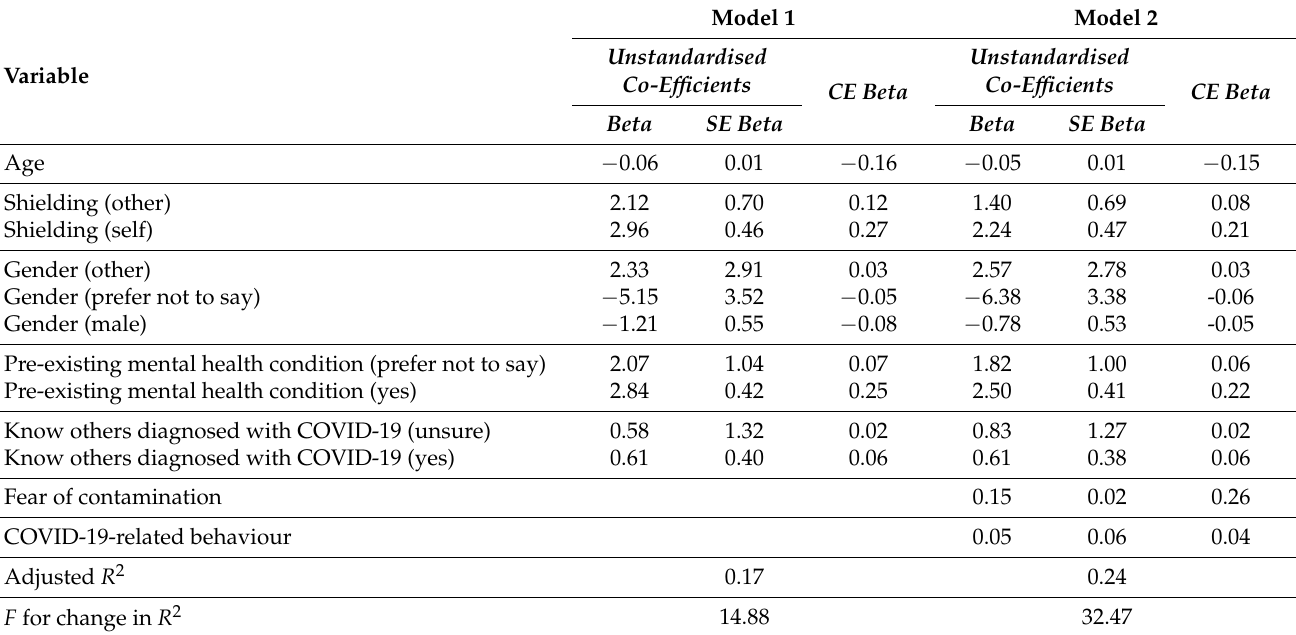
Table 6. Summary of hierarchical multiple regression for predicting generalised